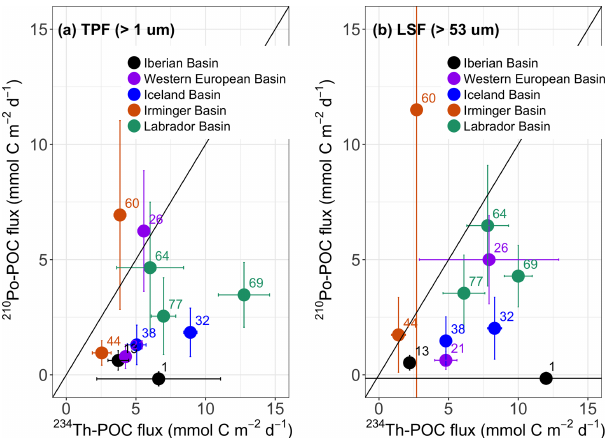
Figure 10. Plot of the POC flux derived from 210 Po ( 210 Po–POC) versus the POC flux derived from 234 Th ( 234 Th-POC) at 11 sta- tions along the GA01 transect. Both the fluxes of 210 Po and 234 Th were calculated from the deficit term alone, assuming steady state and negligible physical transport. The POC / radionuclide ratios on (a) total particulate fraction (TPF, >1µm) and (b) large-size frac- tion (LSF, >53µm) were used to calculate the POC flux. The fluxes were integrated down to the depth at which the 234 Th activity re- turned to equilibrium with 238 U activity (ThEq). The numbers in the plot are station numbers. The colored dots of the stations corre- spond to the